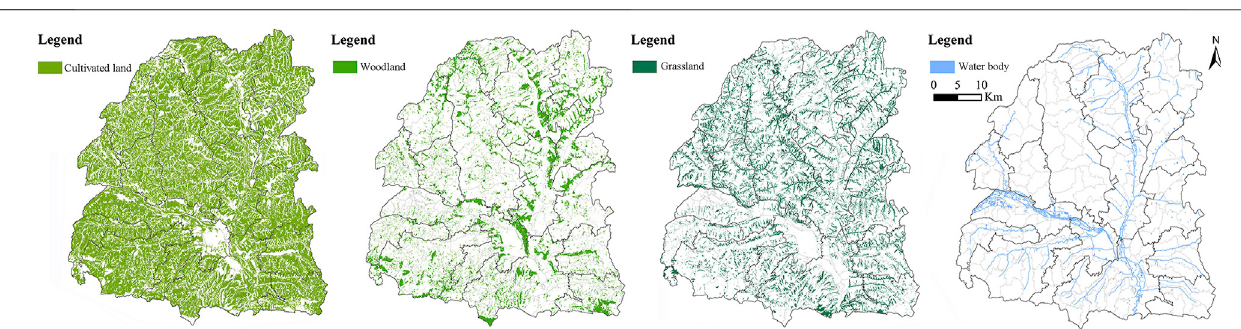
FIGURE 3 | Spatial distribution map of REL.